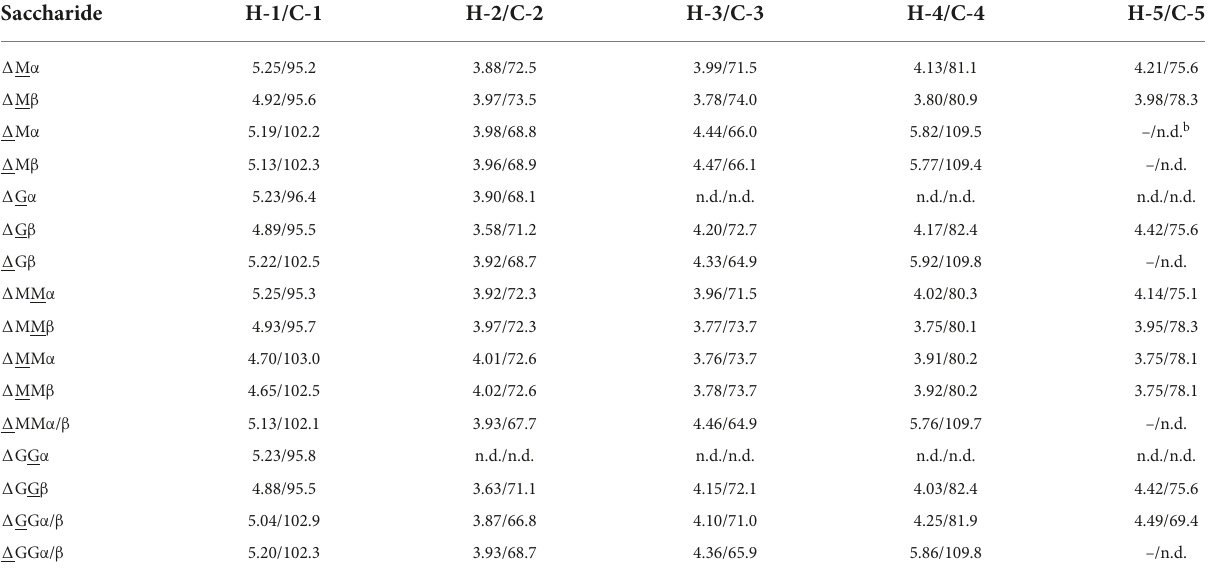
TABLE 2 1 H and 13 C chemical shifts a of (cid:49) M, (cid:49) G, (cid:49) MM, and (cid:49) GG, recorded in D 2 O at 300K.